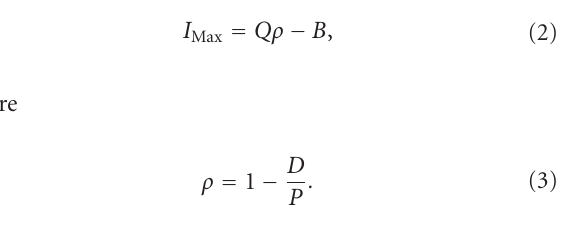
uncertainty, the inventory will have strict seesaw behaviour (cf. Figure